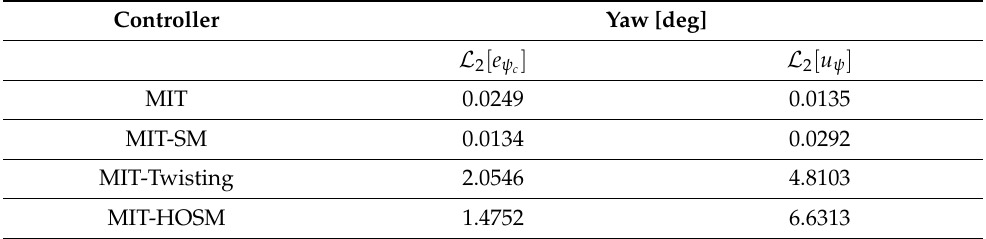
Table 3. Numerical results with L 2 of the adaptive robust controllers in yaw angle.